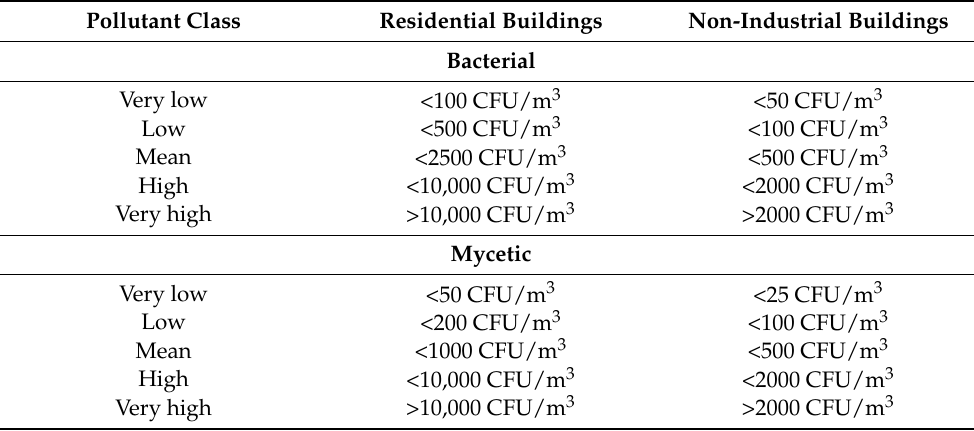
Table 4. Microbiological pollution and IAQ